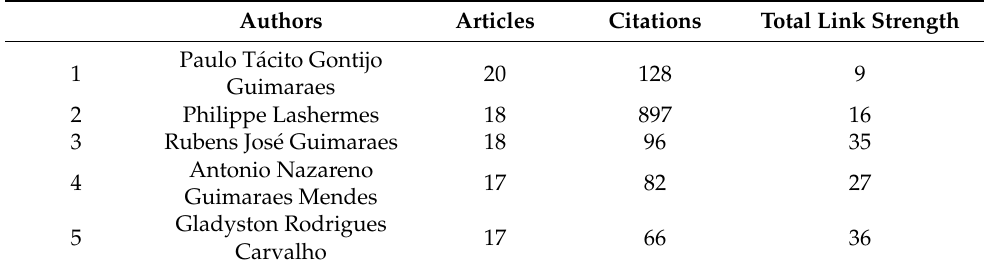
Table 6. Relevant authors in coffee agronomy